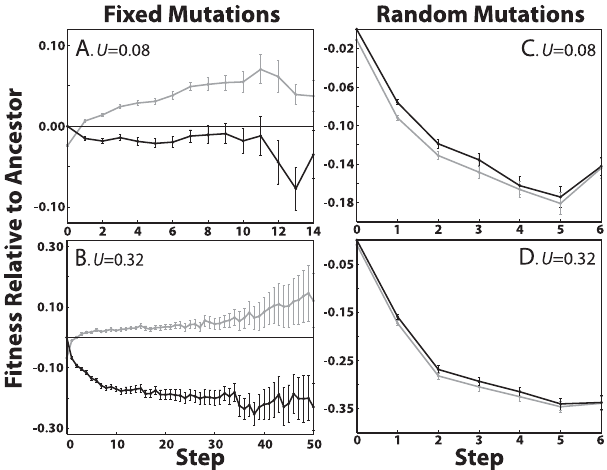
Figure 6. Fixed Deleterious Mutations Are Found in Genotypes That Are More Fit Than the Ancestral Genotype in Which the Deleterious Mutation Arose In each graph, the gray lines correspond to g i and the black lines to g 9 i . We define the fitness of descendent genotypes relative to the ancestor as (( W desc (cid:1) W anc )/W anc ), where W anc is the fitness of the parent genotype that gave rise to the deleterious mutation and W desc may mean the fitness of g i or g 9 i . The error bars depict one standard error of the mean. (A) and (B) show the change in fitness of the genetic backgrounds harboring the fixed deleterious mutations in the U ¼ 0.08 and U ¼ 0.32 runs, respectively. (C) and (D) show the change in fitness of the genetic backgrounds of random deleterious mutations that did not fix in the U ¼ 0.08 and U ¼ 0.32 runs, respectively. DOI: 10.1371/journal.pcbi.0020141.g006